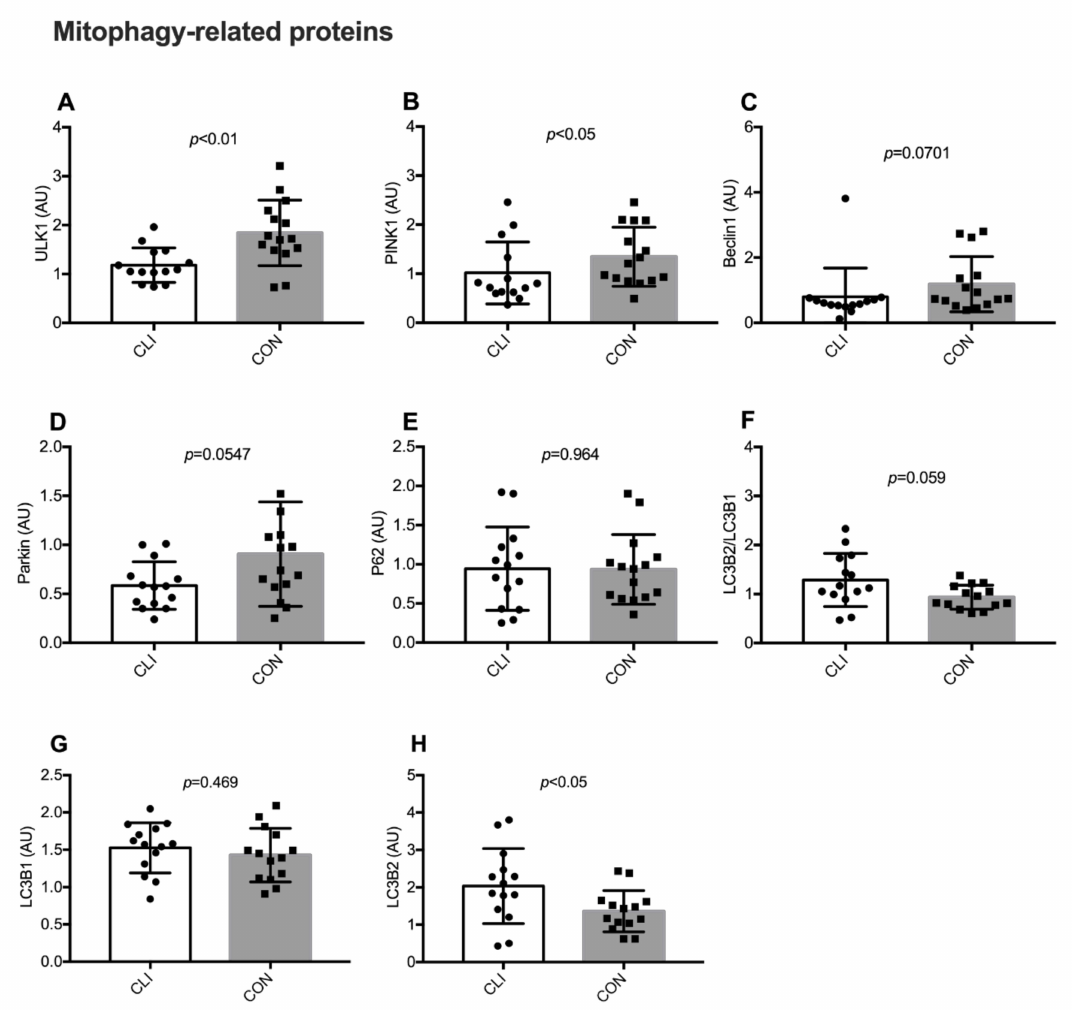
Figure 7. Mitochondrial respiration per mitochondrial volumetric content, CS activity, and cristae content. ( A ) Mitochondrial volumetric content-specific respiration; CLI (n = 14) and CON (n = 14) patients, ( B ) CS activity-specific respiration; CLI (n = 14) and CON (n = 15), and ( C ) cristae-specific respiration; CLI (n = 13) and CON (n = 14). Respiratory states after addition of glutamate and malate (GM), ADP (GM3), succinate (GMS3), and oligomycin (4o). Data are presented as (B) means ± SD and (A, C) medians (25th − 75th)